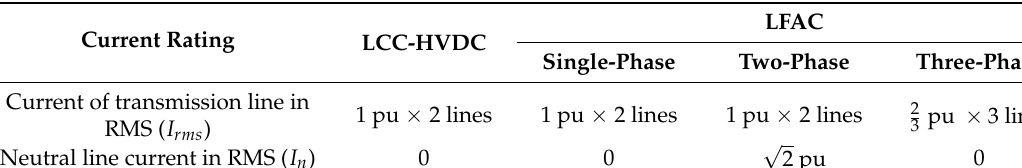
Table 3. Comparison of transmission line rating.